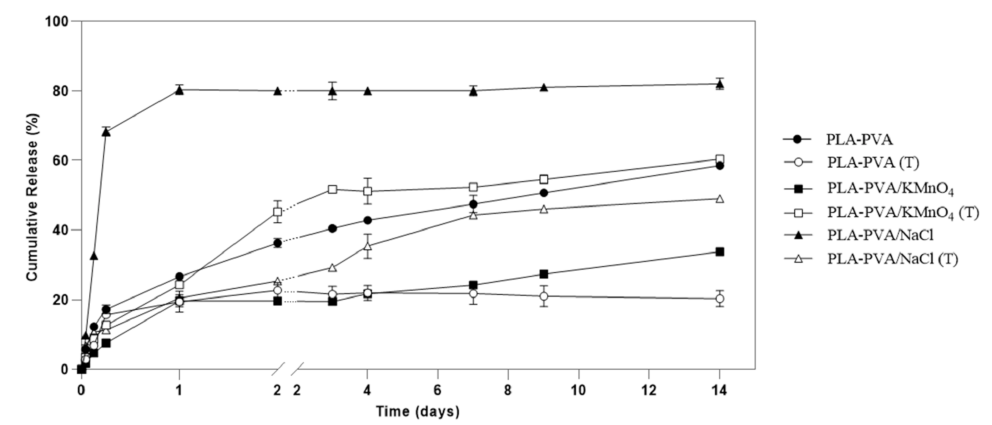
Figure 8. In vitro release profiles of porous bioscaffolds loaded gentamicin sulfate (GS) in pH 7.4 at 37 ◦